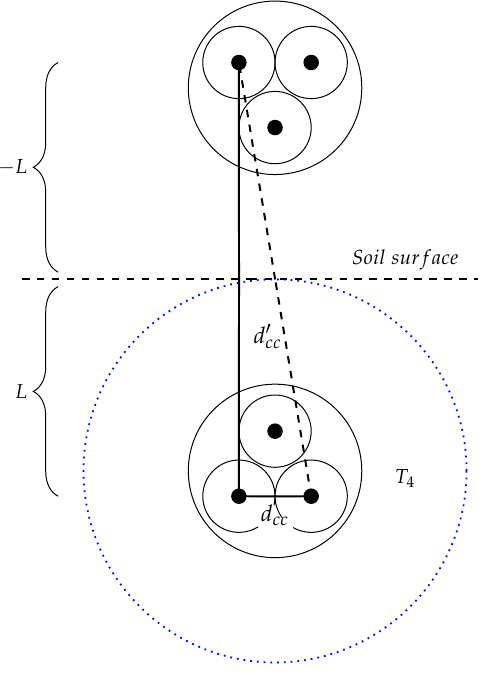
Figure 7. Surrounding cable to soil surface dimensions and mirror of adjacent cable dimensions; representation of the surrounding thermal resistance T 4 (the drawing is not to scale).